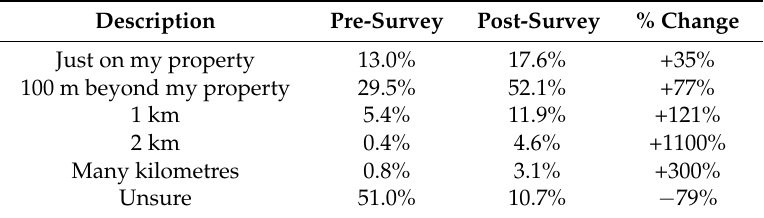
Table 2. Responses to the question “How far from your house do you think [YOUR CAT] goes?” ( n =